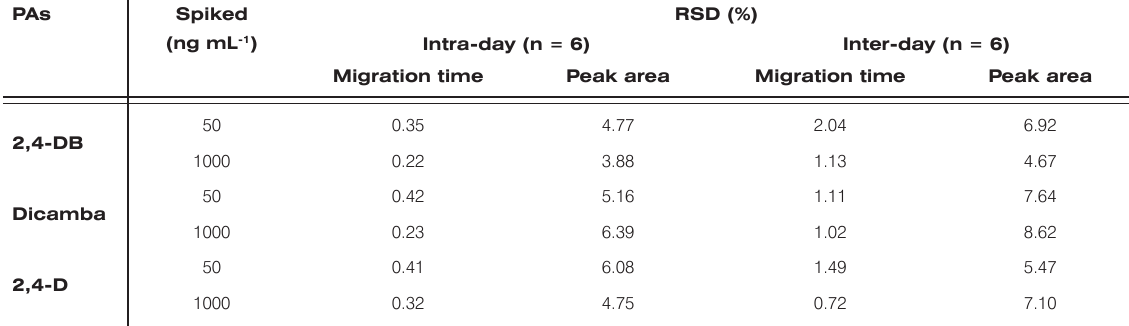
Table 2. Intra-day and inter-day precision of migration time and peak area for the DLLME-MEKC determination of PAs.